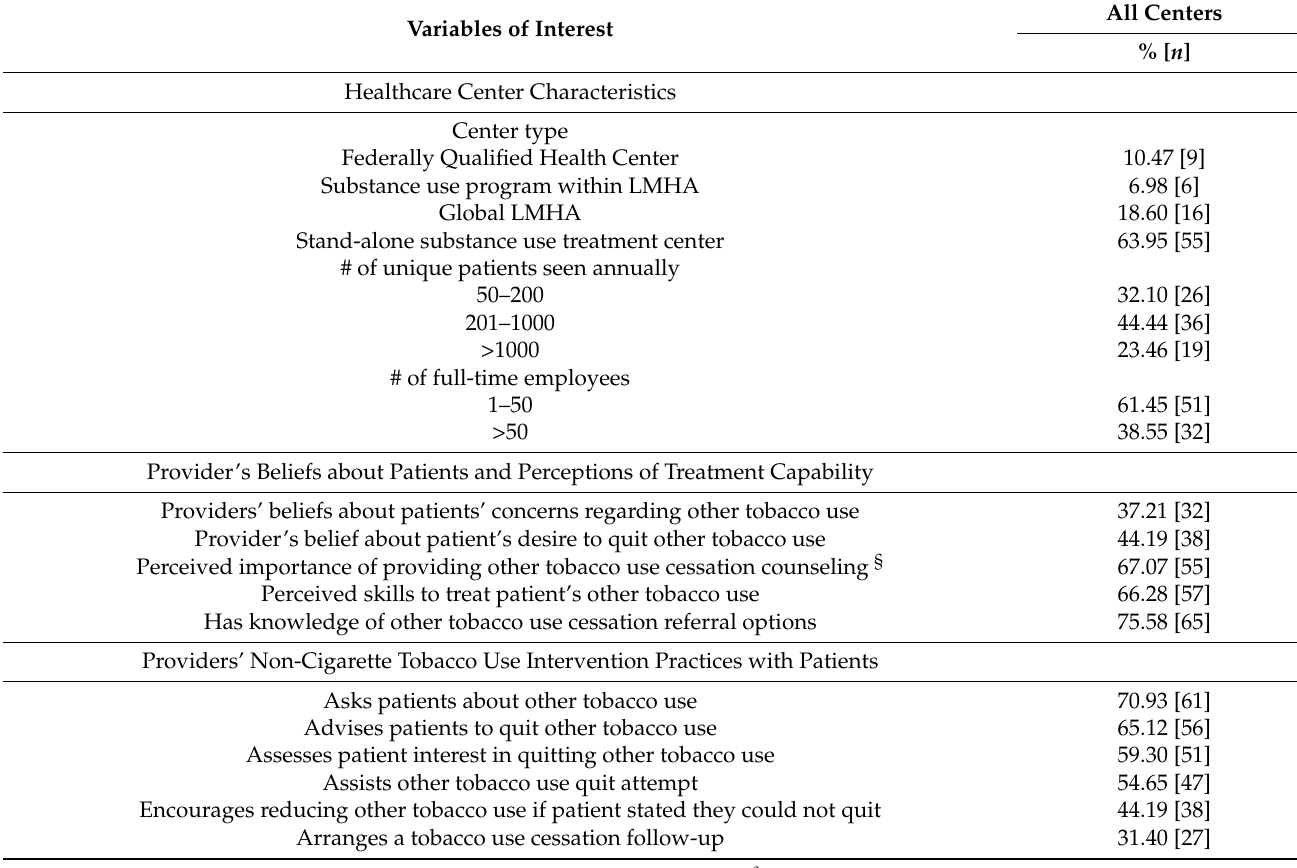
Table 1. Healthcare Center Characteristics; Providers’ Beliefs, Knowledge, Perceived Capacity to Treat Non-cigarette Tobacco Use; Non-cigarette Tobacco Use Intervention Practices ( n = 86 health- care